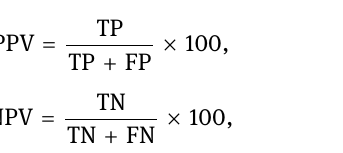
Figure 3: The classi fi cation analysis of the proposed method toward some other state of the art methods.